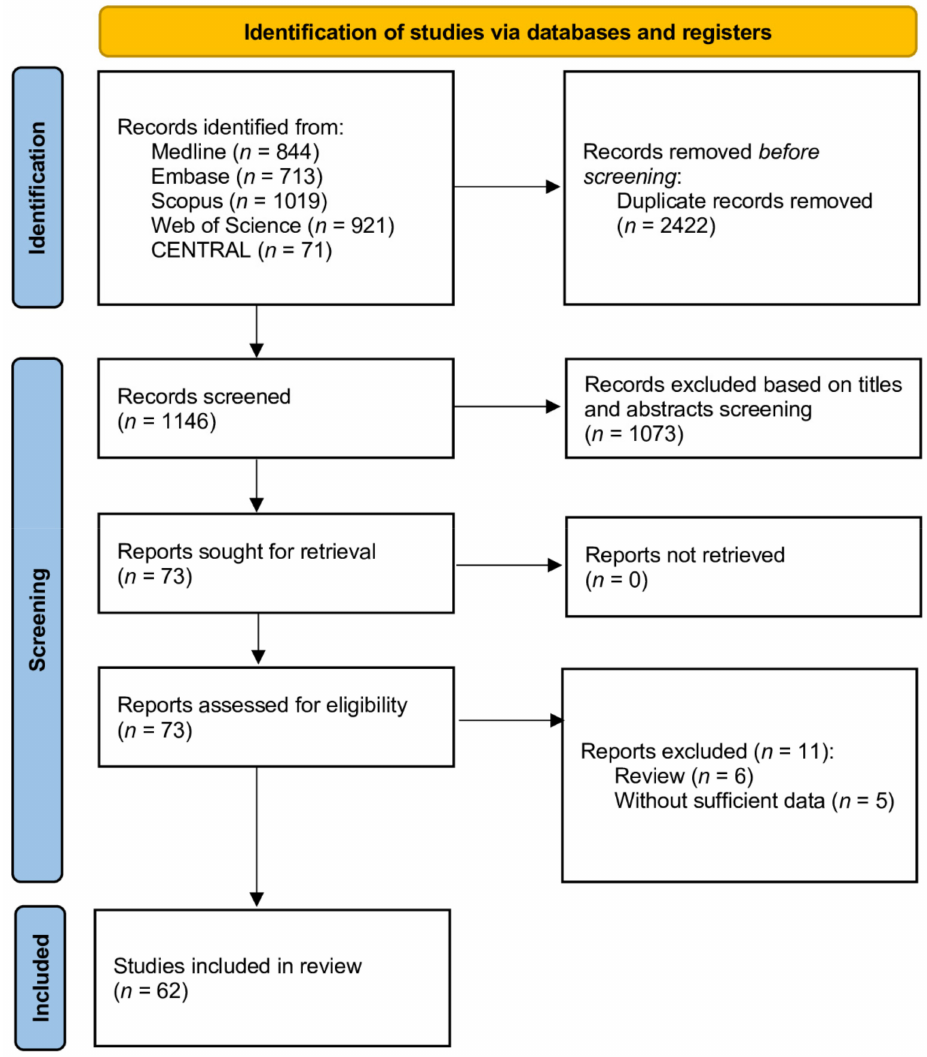
Figure 1. Flow diagram showing stages of database searching and study selection as per Preferred Reporting Items for Systematic reviews and Meta-analysis (PRISMA)